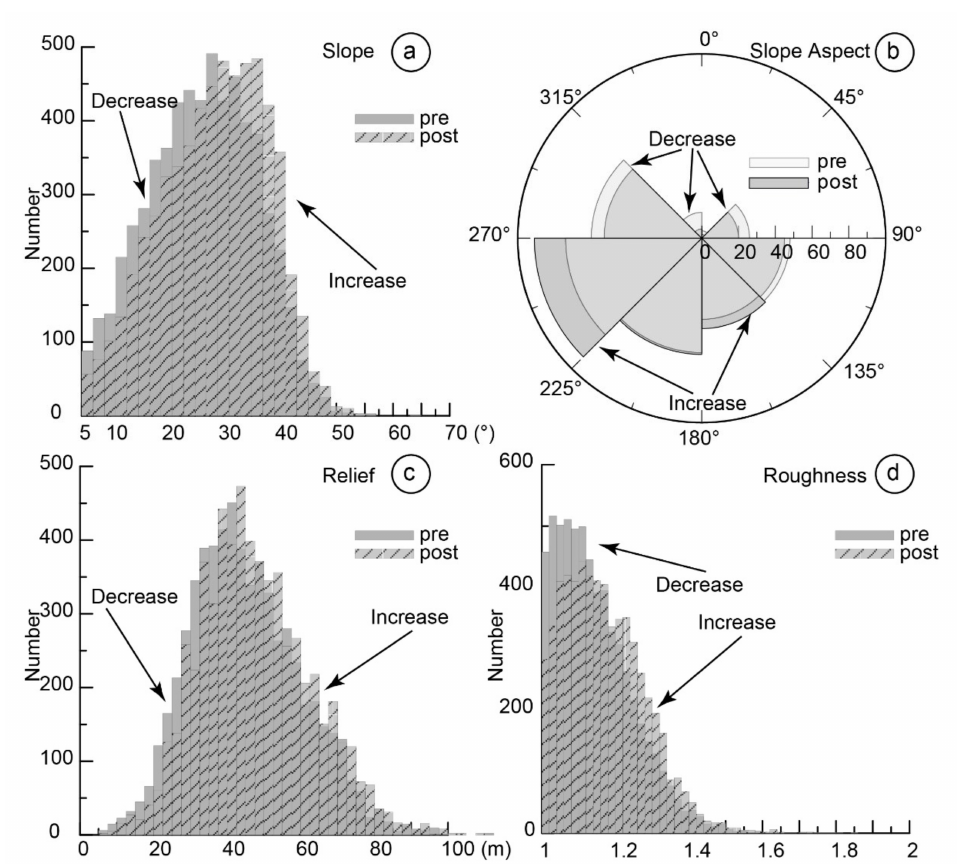
Figure 6. Statistical comparison of the pre- and post-earthquake slope angle ( a ), slope aspect ( b ), relief ( c ) and roughness ( d